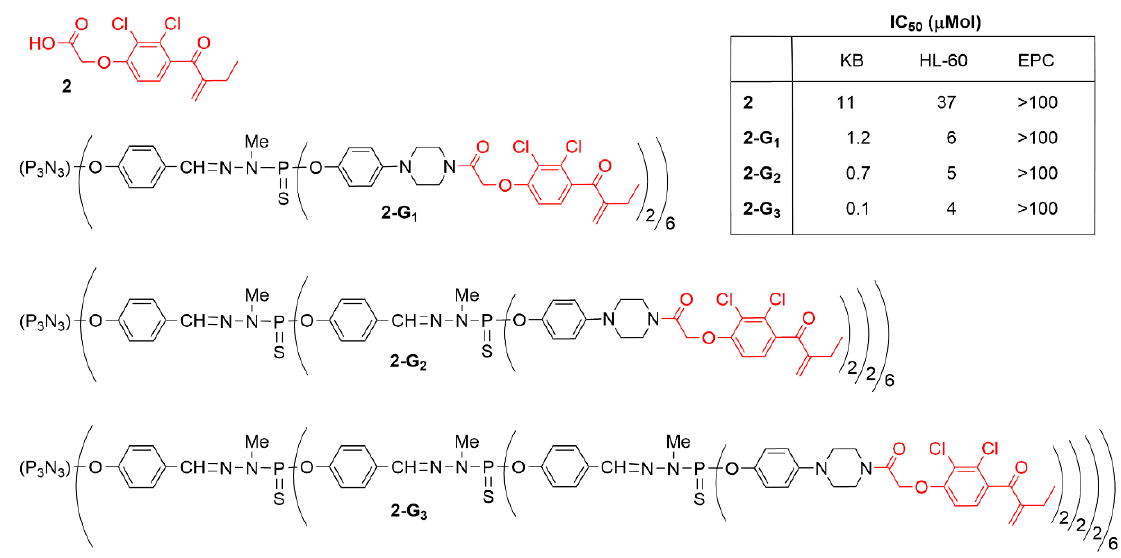
Figure 3. Ethacrynic acid ( 2 ), and generations 1 to 3 of phosphorhydrazone dendrimers functionalized with ethacrynic acid. IC 50 values (in micromols) against two cancerous cell lines (KB and HL-60), and one non-cancerous (EPC).